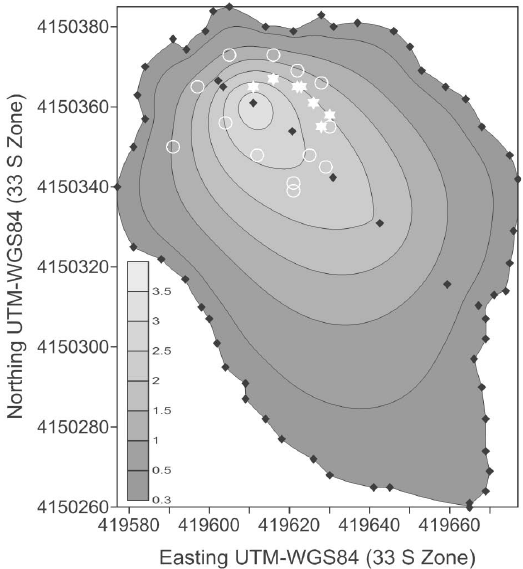
Fig. 5. Isopach map of the 11 August 2008 mud volcano deposit; black diamonds are the thickness measuring points, white void cir- cles the mud emitting vents, white stars the gas emitting